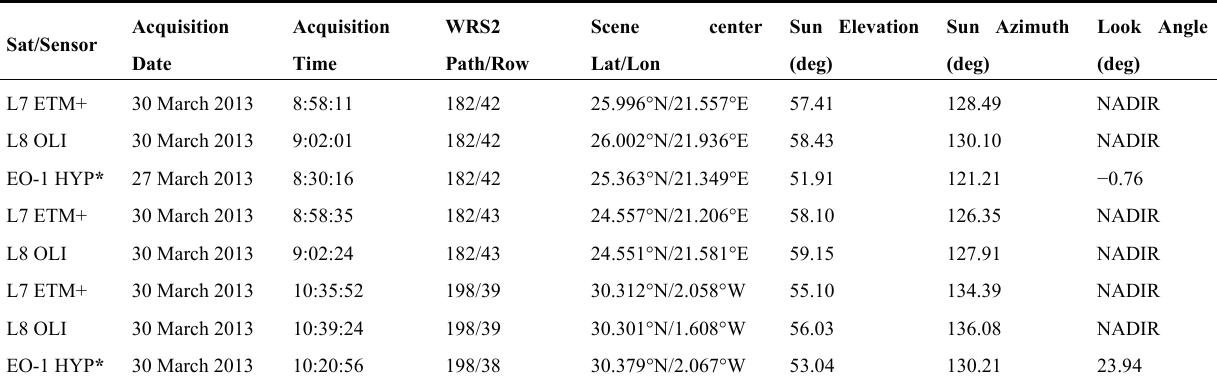
Table 1. Metadata of scenes used for L7/L8 cross-calibration.